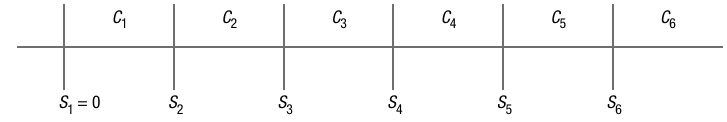
Fig. 5. Scale of categories of difference of attractiveness